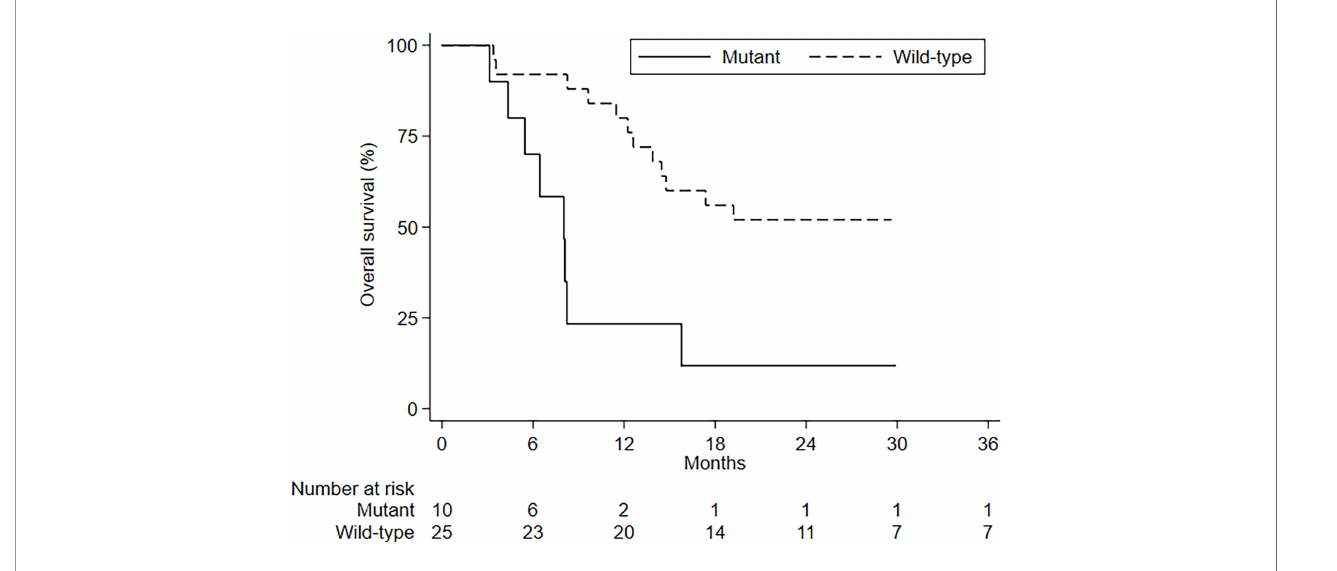
FIGURE 4 | OS by KRAS